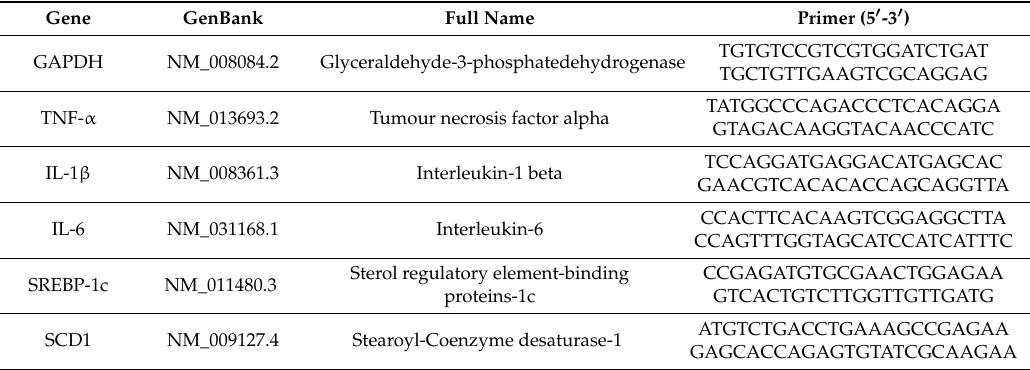
Table 1. Primer sequences used for real-time